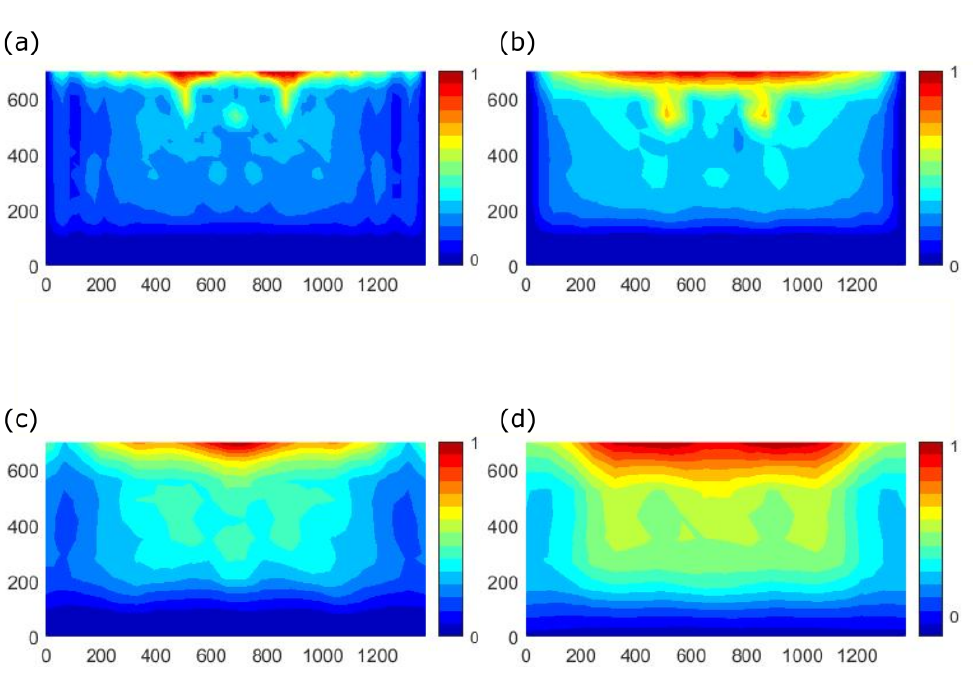
Figure 13. Figures showing normalized and mirror averaged wear maps for mesh edge lengths, ( a ) 30 mm, ( b ) 45 mm, ( c ) 60 mm, and ( d ) 75 mm. The particle size distribution is the smaller one with radius, R = 50 mm. Color plots are showing the normalized wear depth in